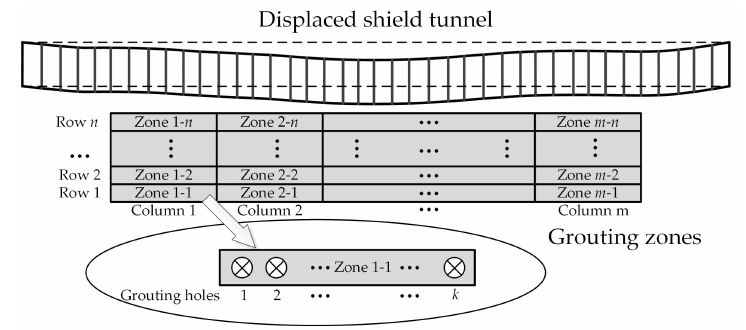
Figure 1. Plan view of a typical grouting scheme in the remediation